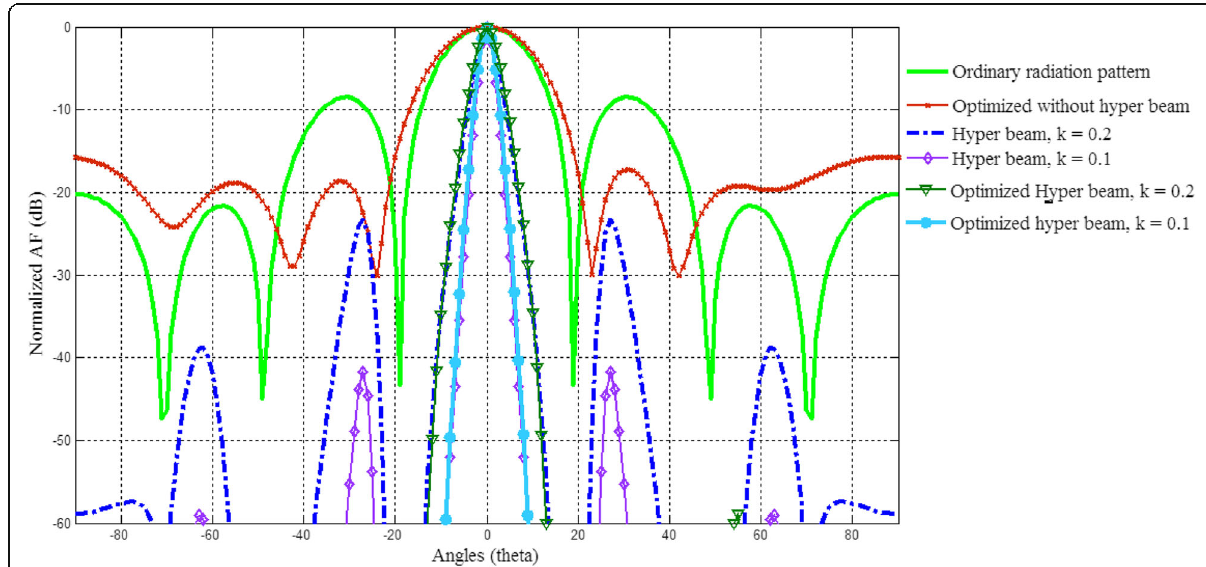
Fig. 4 Effect of the hyper beam